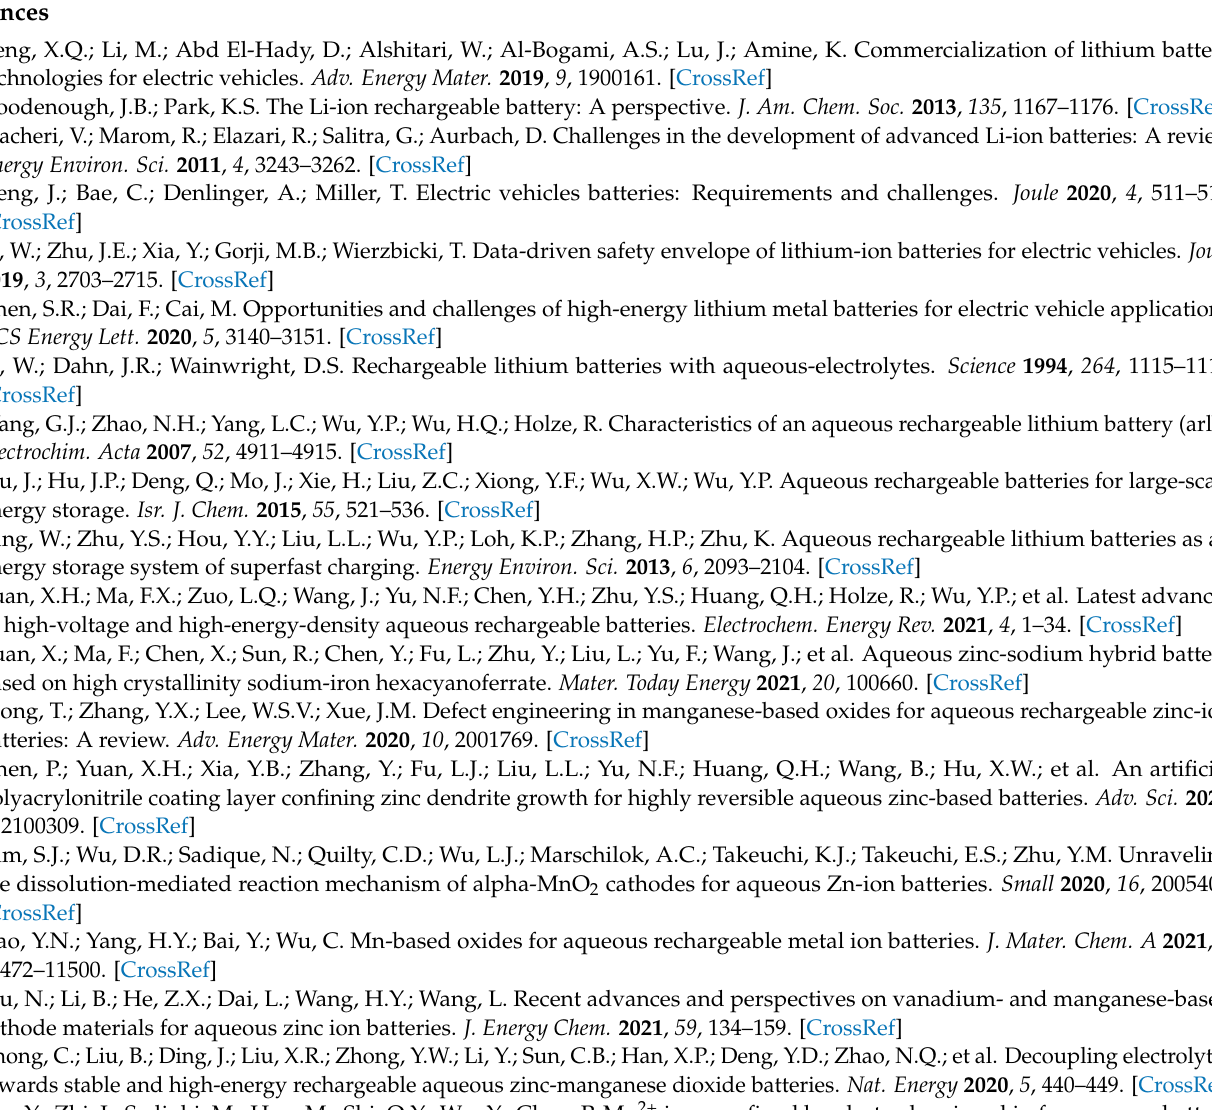
Figure S4: Electrochemical charge–discharge curves at a current density of 0.5 A g − 1 over the potential range 0.1–1.95 V: (a) MnO 2 , (b) MnO 2